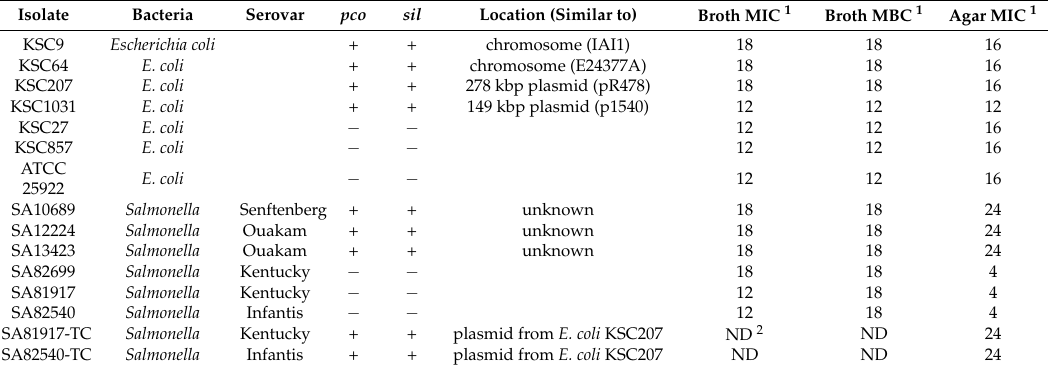
Table 2. Isolates used in this study for copper susceptibility testing. All reported minimum inhibitory concentration (MIC) values were determined under anaerobic conditions. MBC—minimum bactericidal